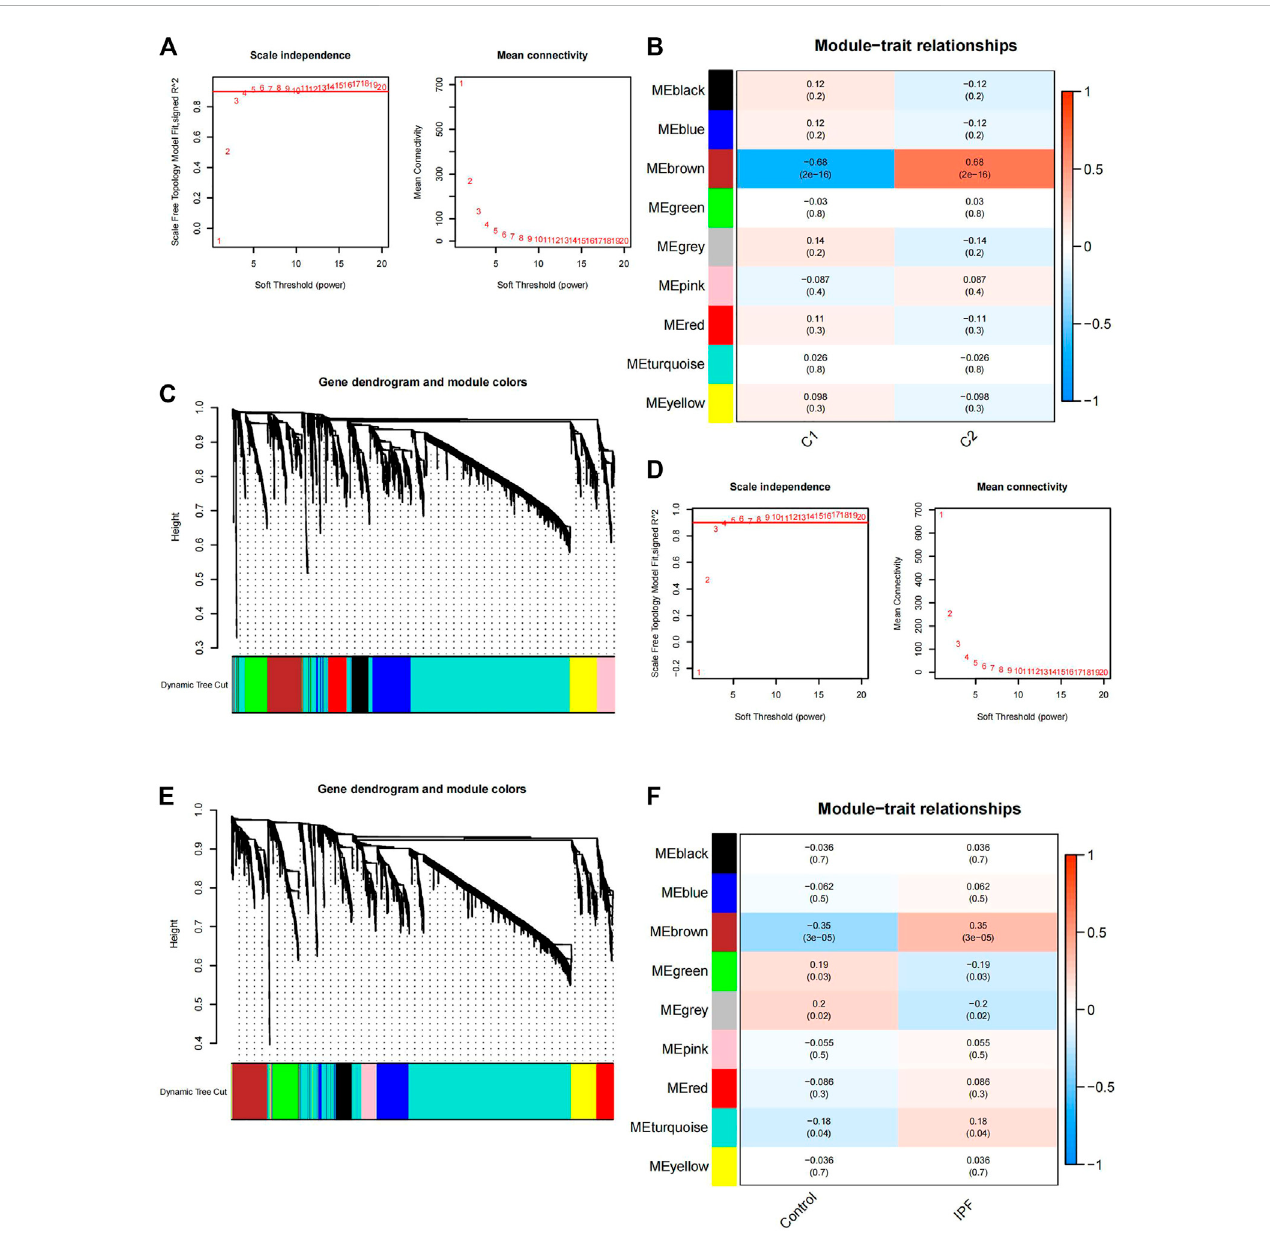
FIGURE 5 GenemoduleselectionusingWGCNA. (A) Selection ofthesoftthresholdpowerinclustersoneandtwo.Whenthescale-free fi tindexis.9,theminimum soft threshold is 4. (B) Gene clustering tree in cluster 1 and cluster 2. C1 is cluster 1, C2 is cluster 2. (C) Correlation heatmap between the co-expression modules in clusters 1 and 2; the brown module has the highest correlation and the lowest p -value ( P = 2e-16) in cluster 1 (correlation = − .68) and cluster 2 (correlation= .68). (D) Selection of thesoftthreshold power for the 112 IPF and 20 control samples. When thescale-free fi t index is .9, the minimum soft threshold is 4. (E) Gene clustering tree of the 112 IPF and 20 control samples. (F) Correlation heatmap between the co-expression modules in the 112 IPF and 20 control samples; the brown module has the highest correlation and the lowest p -value ( P = 3e-05) in cluster 1 (correlation = − .35) and cluster 2 (correlation = .35). WGCNA, weighted gene co-expression network analysis; IPF, idiopathic pulmonary fi